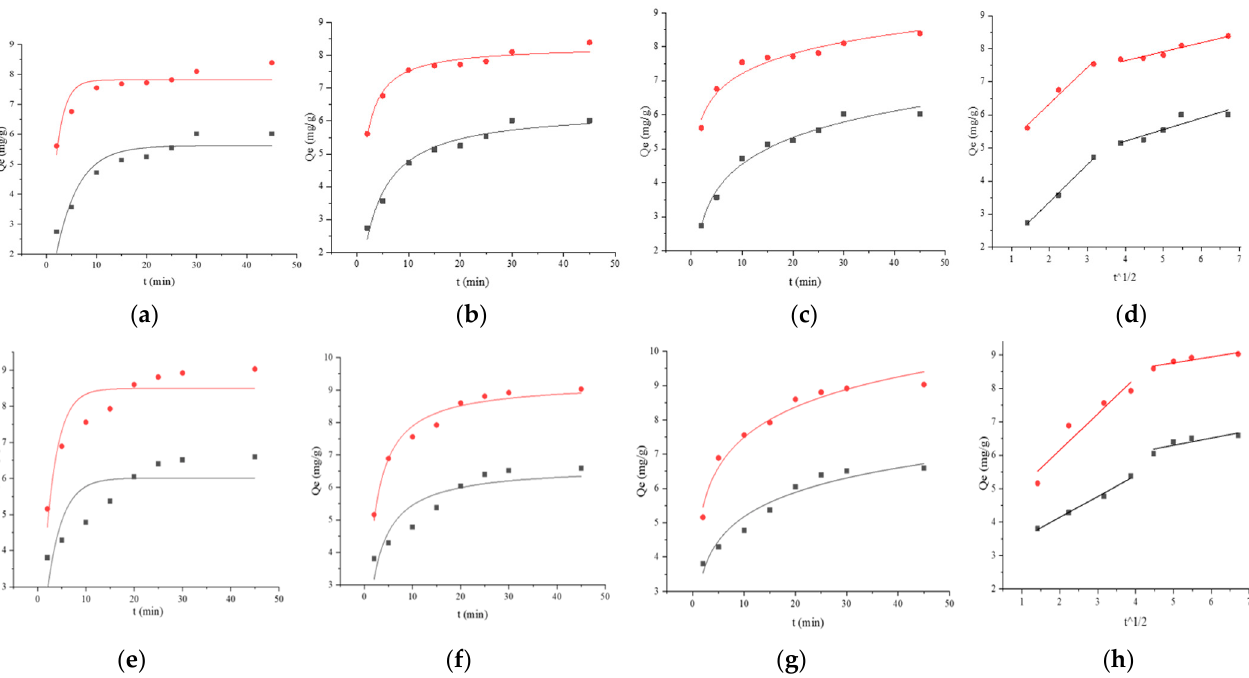
Figure 6. ( a ) Adsorption isotherms of BaP; 121, 121 + BSA, ML32, and ML32 + BSA. ( b ) Isotherm model s of BaP; 121, 121 + BSA, Langmuir, Freundlich, Langmuir, and Freundlich. ( c ) Isotherm models of BaP; ML32, ML32 + BSA, Langmuir, Freundlich, Langmuir, and Freundlich. Table 4. The Langmuir and Freundlich isothermal model fitting results.